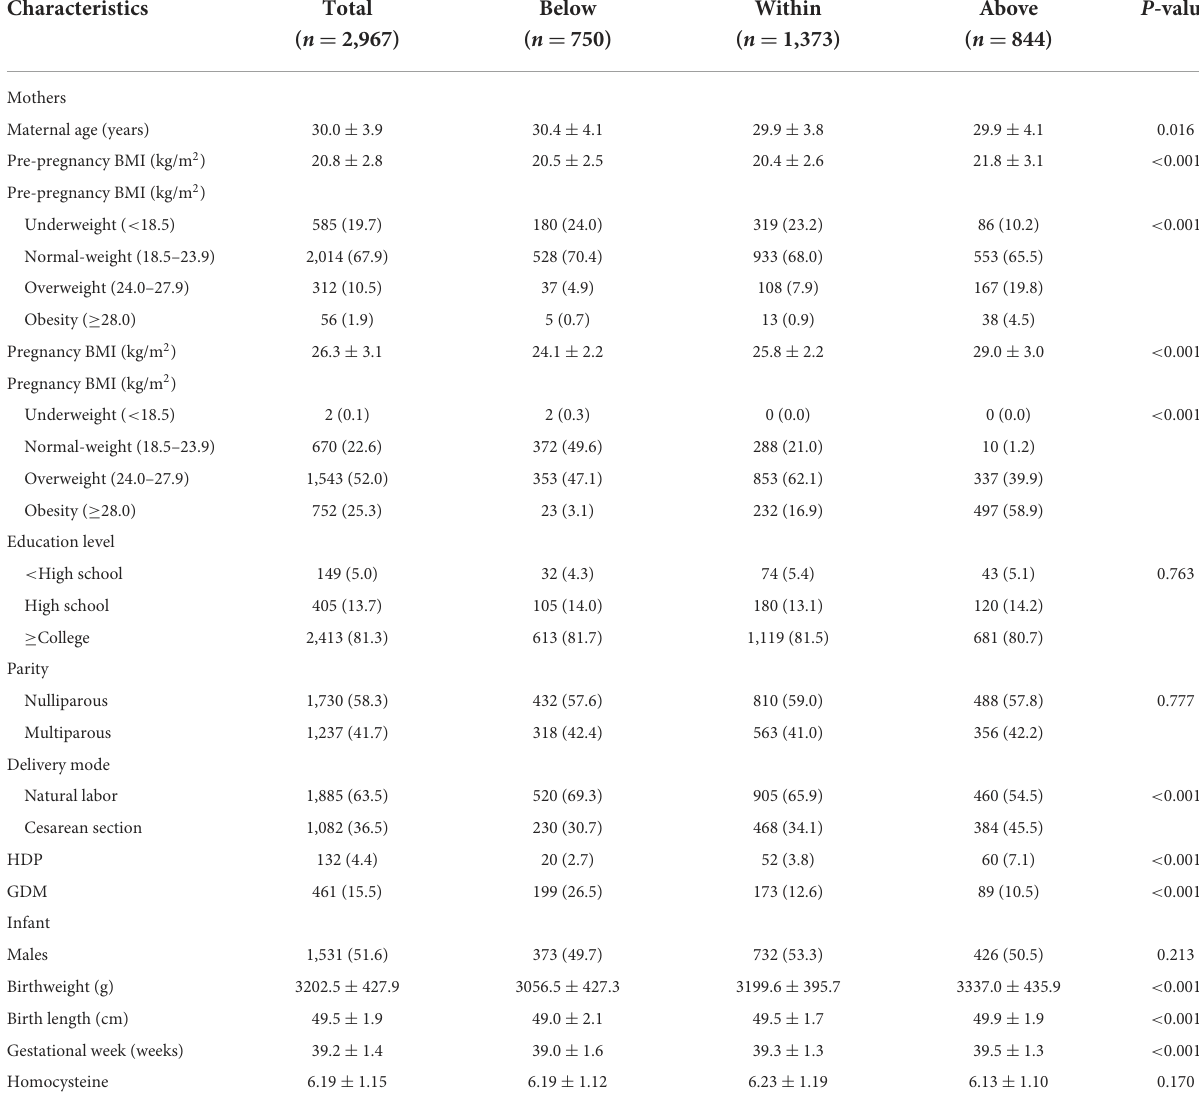
TABLE 1 Basic characteristics of study population according to the IOM guidelines ( n =